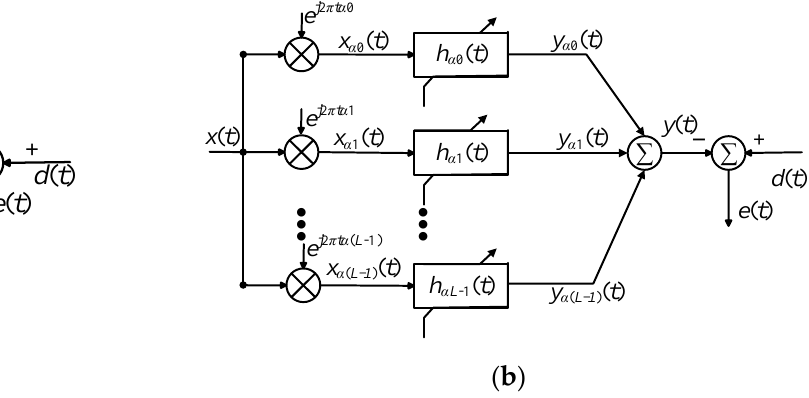
Figure 1. ( a ) Diagrams of the adaptive filter; ( b ) diagrams of the cyclic Wiener